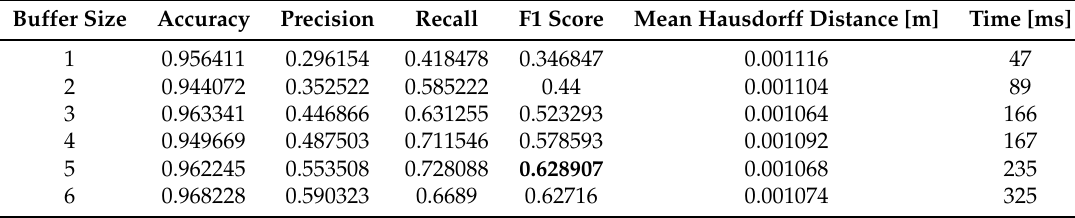
Table 2. ROR filter best results for multiple buffer sizes.